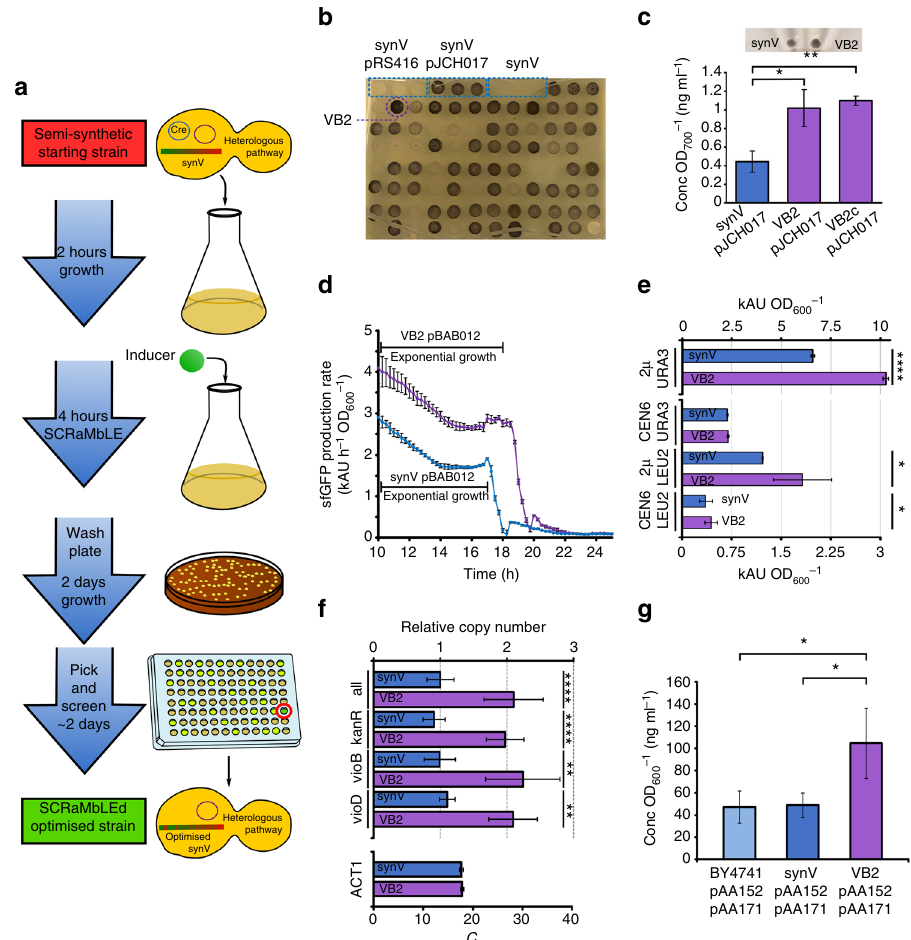
Fig. 1 Optimising a synV host by SCRaMbLE for enhanced violacein production. a The work fl ow of a SCRaMbLE host optimisation process. b Eighty seven post-SCRaMbLE synV-pJCH017 colonies and synV, synV-pRS416 and synV-pJCH017 controls were grown in liquid culture, spotted onto SDO URA − agar medium and grown for 2 days. The best performing strain, VB2, is highlighted. c Results of colourimetric determination of violacein yields from synV- pJCH017, VB2-pJCH017 and VB2c-pJCH017 cultures, n = 3. Inset are microtubes in which equal volumes of synV-pJCH017 and VB2-pJCH017 culture, normalised for OD 700 , have been pelleted by centrifugation. d sfGFP production rates from synV-pBAB012 and VB2-pBAB012 cultures, n ≥ 7. Data shown are the increase in 520nm fl uorescence value over the previous hour normalised to the OD 600 value at the midpoint of that hour. e The 520 nm fl uorescence levels of cultures of synV and VB2 strains containing pBAB011 ( CEN6 / URA3 ), pBAB012 (2 μ / URA3 ), pBAB015 ( CEN6 / LEU2 ) or pBAB016 (2 μ / LEU2 ) plasmids after 29.5 h of growth. Fluorescence values are normalised for OD n ≥ 7. f qPCR evaluation of pJCH017 copy number in total DNA 600 , preparations from stationary synV-pJCH017 and VB2-pJCH017 cultures. The vioD , vioB and kanR targets are located on pJCH017 and 'all' represents the combined data from ampli fi cation of these three loci. Relative copy number is the calculated concentration of pJCH017 in the total DNA for each experiment normalised to the combined synV-pJCH017 value. The ACT1 control shows the threshold cycle for ampli fi cation of a chromosomal ACT1 target for each DNA preparation, demonstrating equal levels of genomic DNA, n = 6 (2 technical replicates each of 3 biological replicates). g The amount of penicillin G secreted by BY4741-pAA152/171, synV-pAA152/171 and VB2-pAA152/171 strains as determined by LC-MS. Values are normalised for OD 600 , n = 3. All values plotted are mean averages and error bars represent 1 standard deviation from the mean. Replicate numbers represent biological replicates except where otherwise stated. Asterisks denote two-tail p -value as determined by two-sample t -test, with * p ≤ 0.05, ** p ≤ 0.01, and **** p ≤